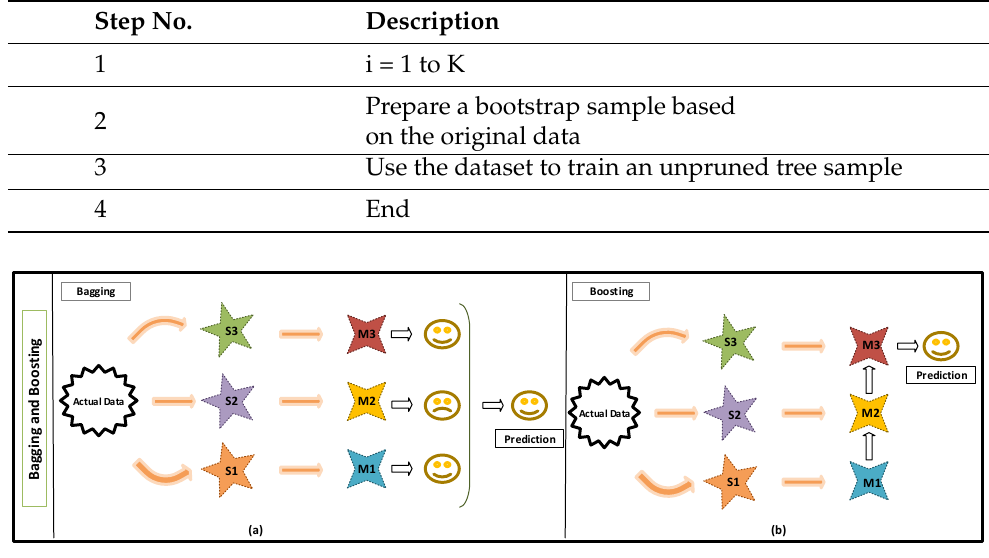
Table 2. Explanation of steps in the bagging trees algorithm.